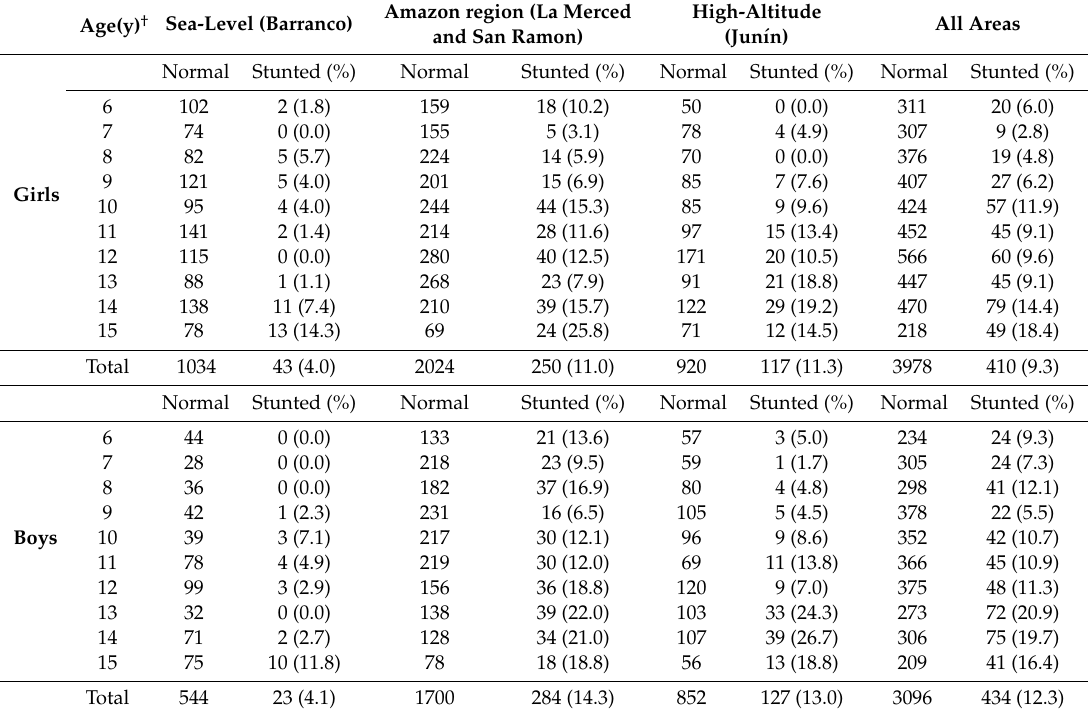
Table 1. Sample size and prevalence of stunting (%) by age, sex and geographical area of residence. Age(y) † Sea-Level